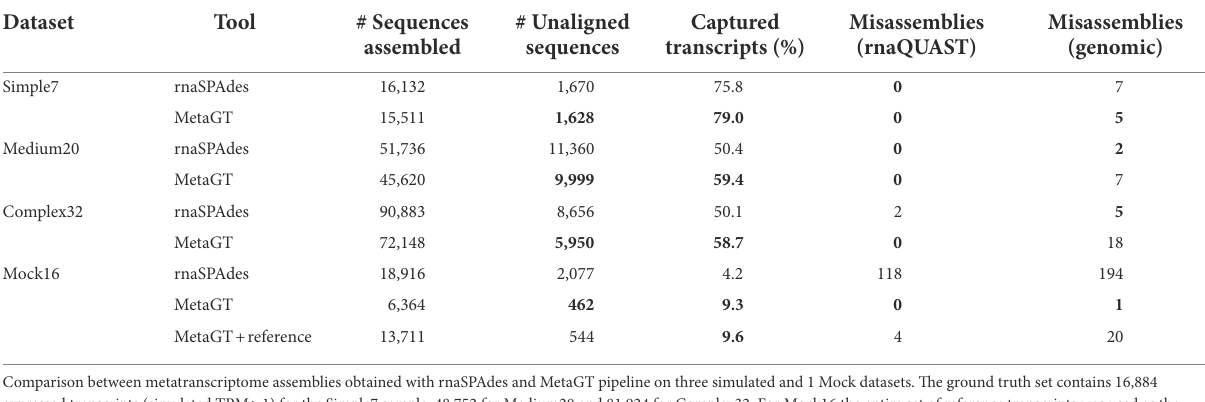
TABLE 2 Assembly results on simulated data and synthetic